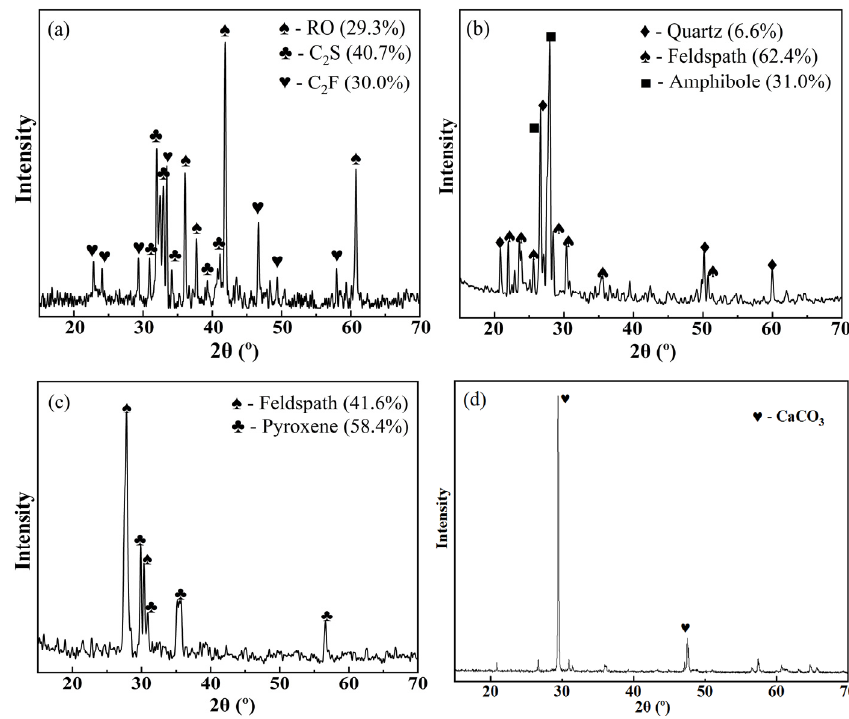
Figure 7. ( a–d ) are the XRD spectra of steel slag, granite, basalt, and limestone, respectively. Table 2. H and STR of